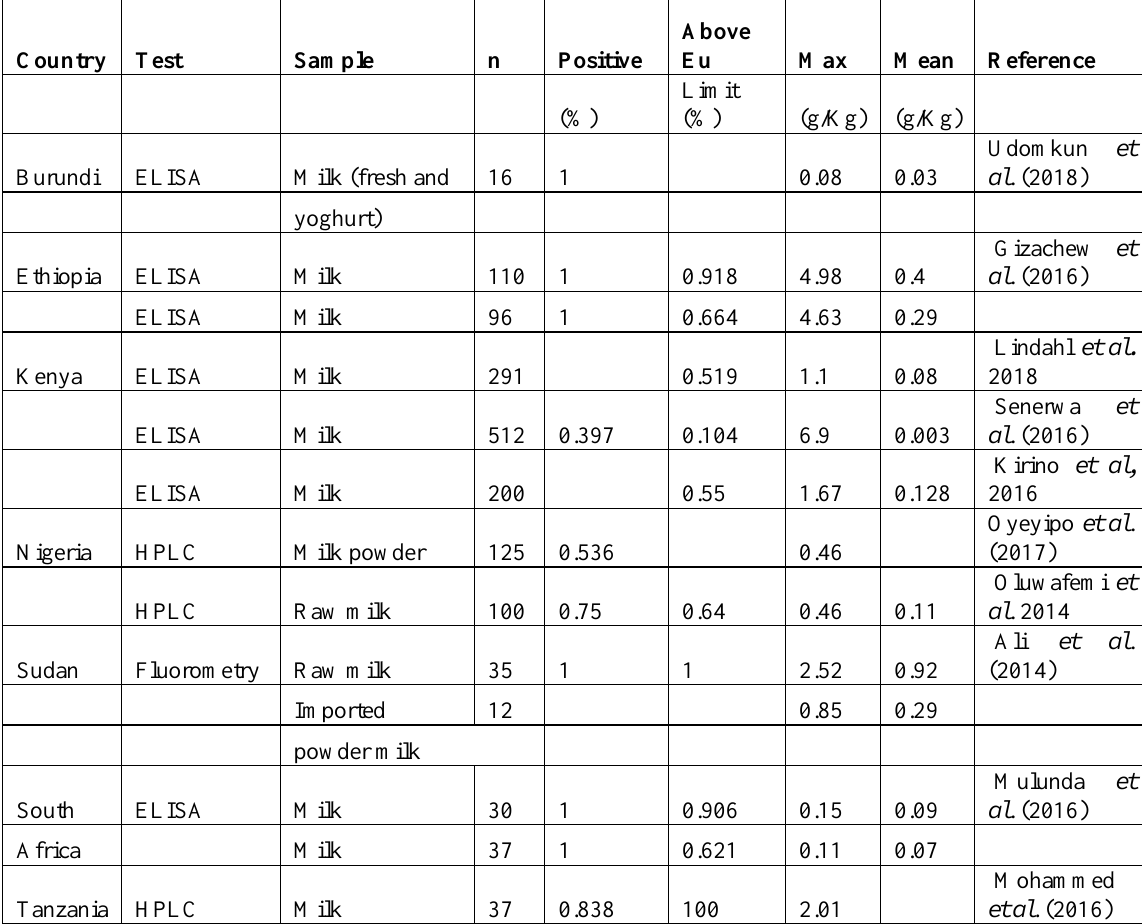
Table 2. Aflatoxin M1 in milk in Sub-Saharan